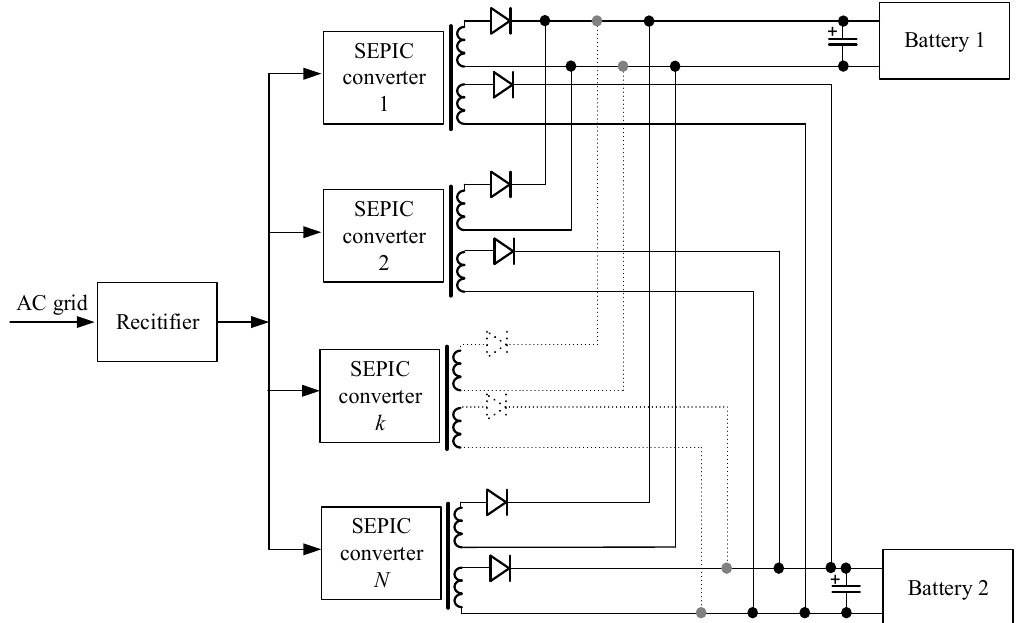
Figure 4. A single-ended primary-inductor converter (SEPIC) cell: ( a ) Typical, ( b ) isolated, ( c ) multiple output.